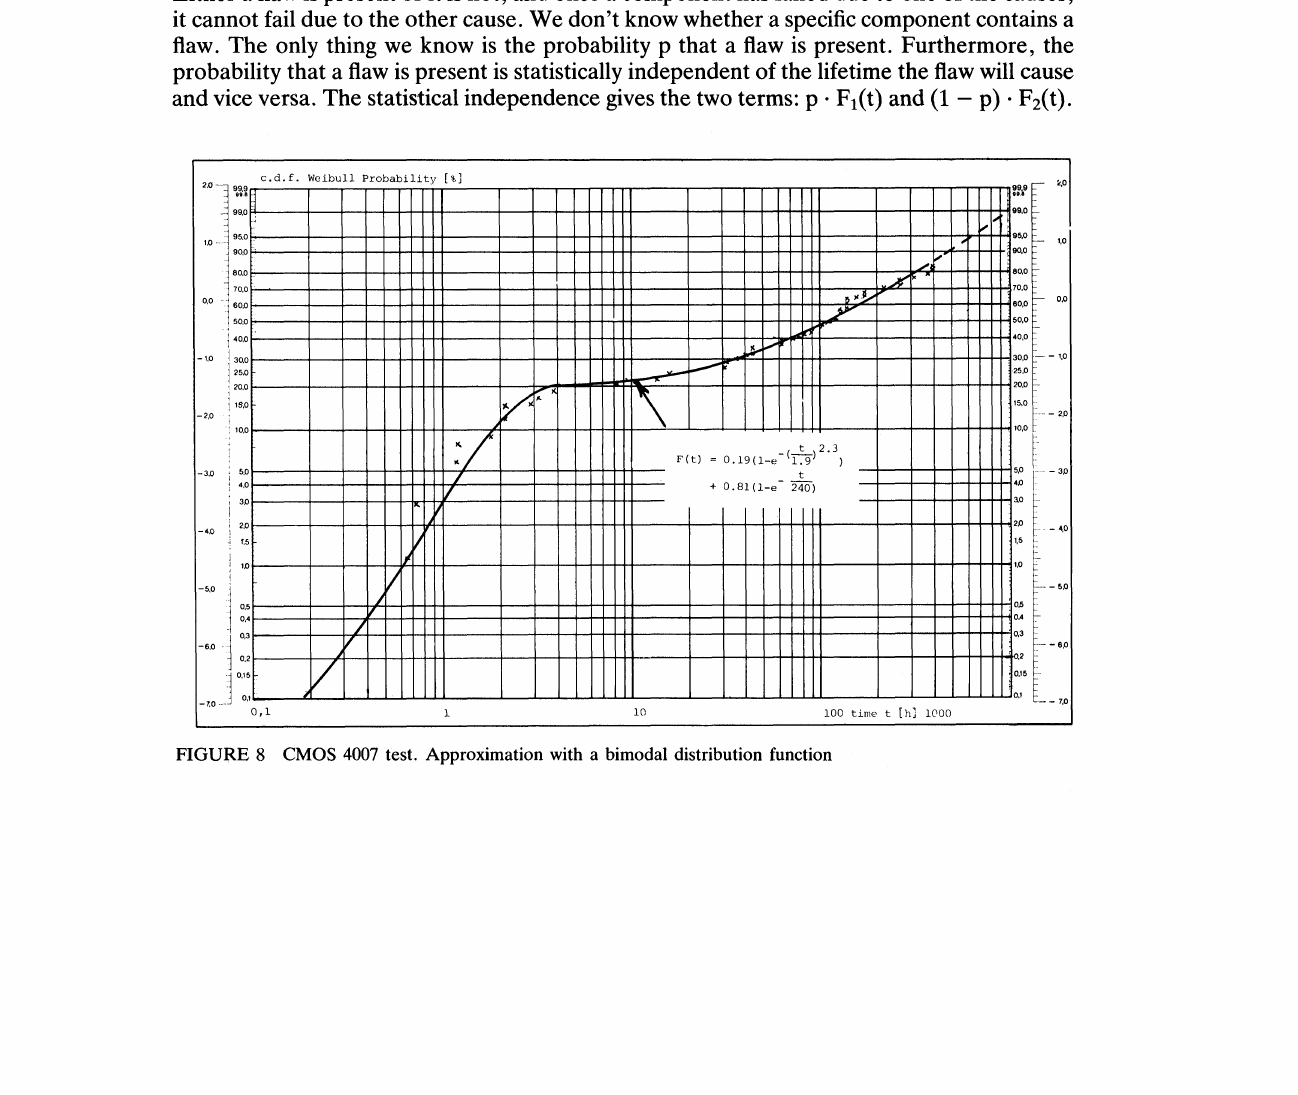
FIGURE 8 CMOS 4007 test. Approximation with a bimodal distribution